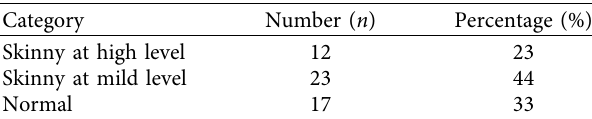
Table 3: The distribution of nutritional status of female models in Malang City.